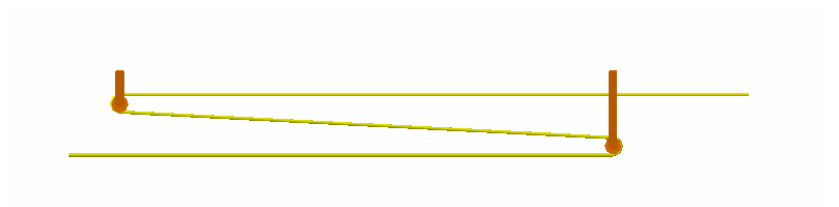
Figure 5 . The NiTi wire wound around the slipper.